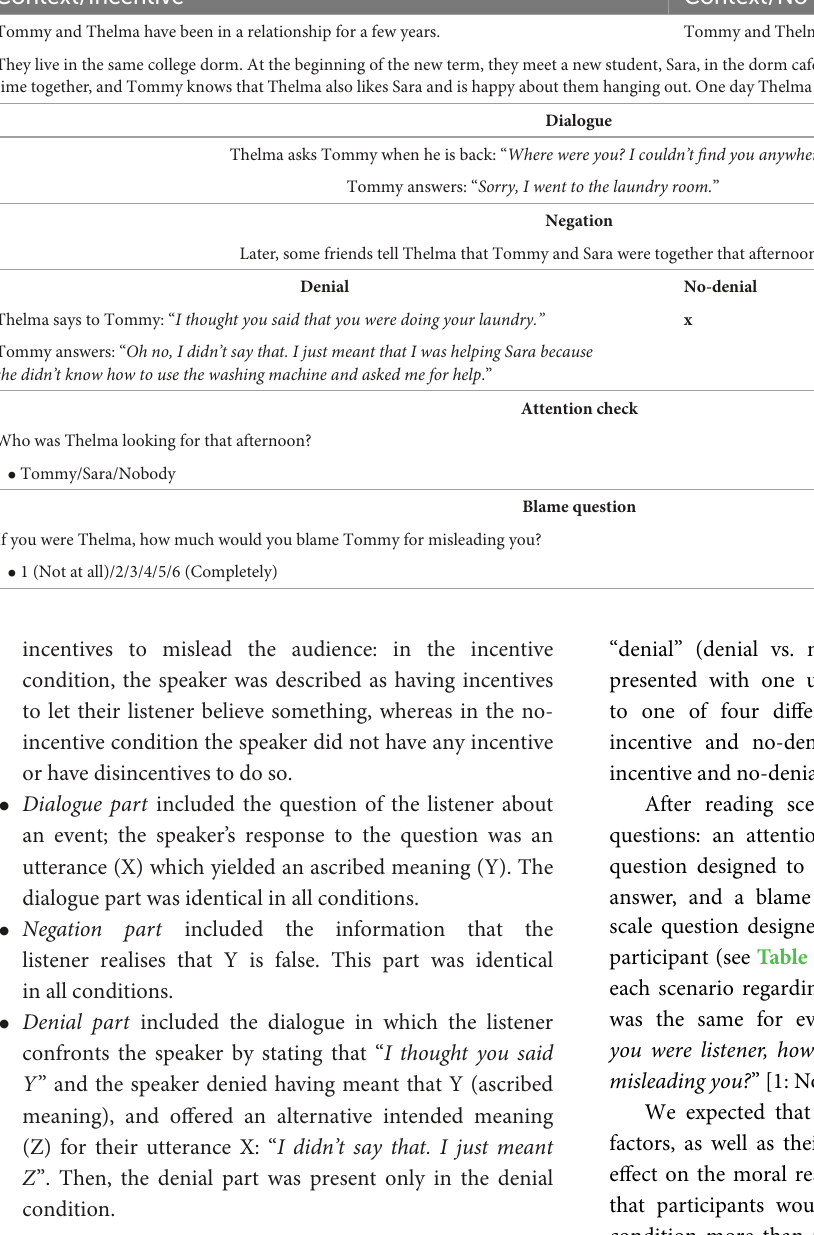
TABLE 1 Example of scenarios structure and measures under four different conditions presented in Experiment 1. Context/Incentive Context/No-incentive Tommy and Thelma have been in a relationship for a few years. Tommy and Thelma are siblings and have a very close